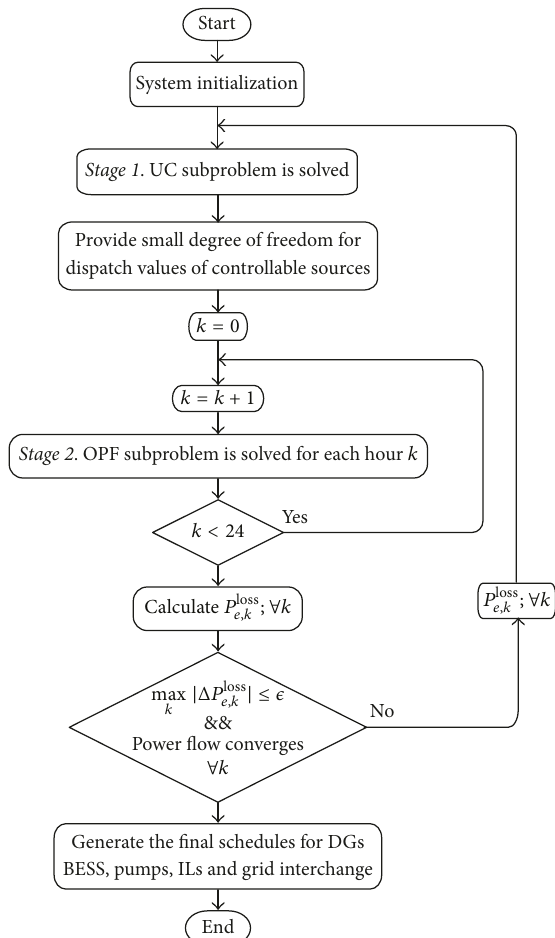
Figure 1: Flowchart for EMS layer computations. the power flow direction. Here, 𝛼 is a positive parameter value denoting the small degree of freedom permitted around the optimal dispatch values calculated in Stage 1. This parameter should be wisely chosen as a lower 𝛼 leads to slower convergence and a higher 𝛼 will result in the connection between Stage 1 and Stage 2 being lost. In this paper, 𝛼 is taken as 0.03. The uncontrollable sources such as the RESs are fixed in a similar manner to Stage